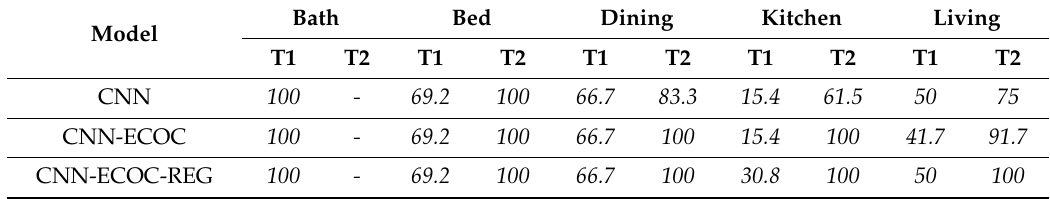
Table 5. Confusion matrix of testing images with top-1 & top-2 for five classes. Top-1 with CNN Top-2 with CNN